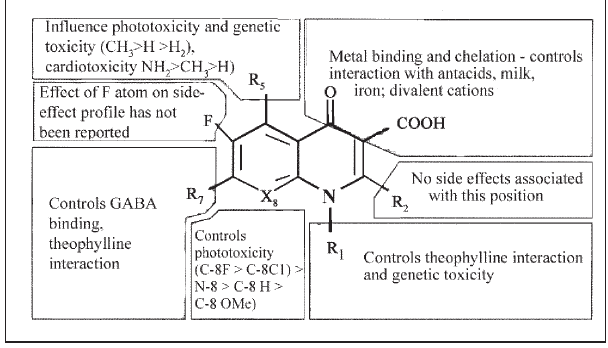
Figure 2) Structure of adverse reaction relationships of fluoro- quinolone. Adapted from reference